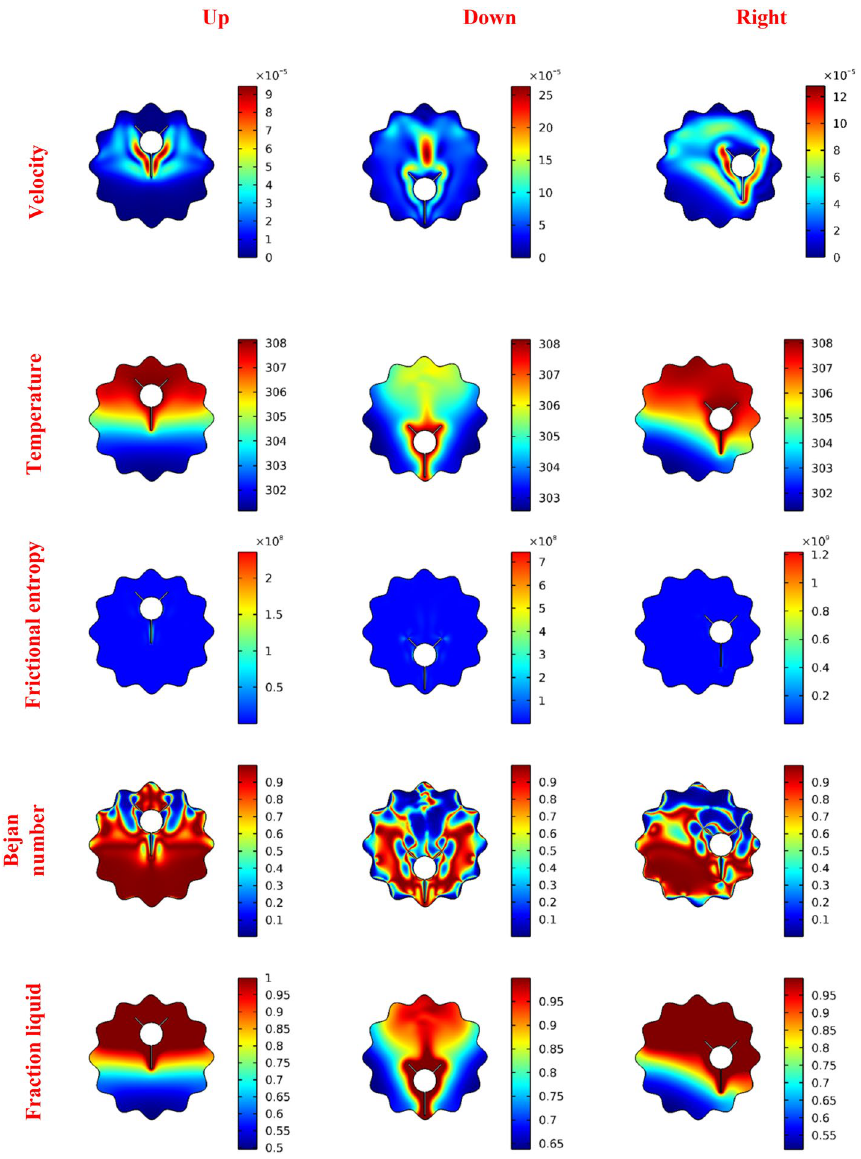
Figure 5. The impact of the finned tube position on the velocity, temperature, frictional entropy, Bejan number, and Liquid fraction contour after 30